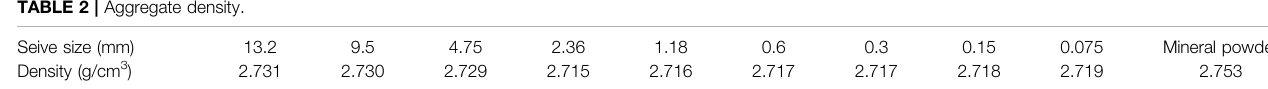
TABLE 2 | Aggregate